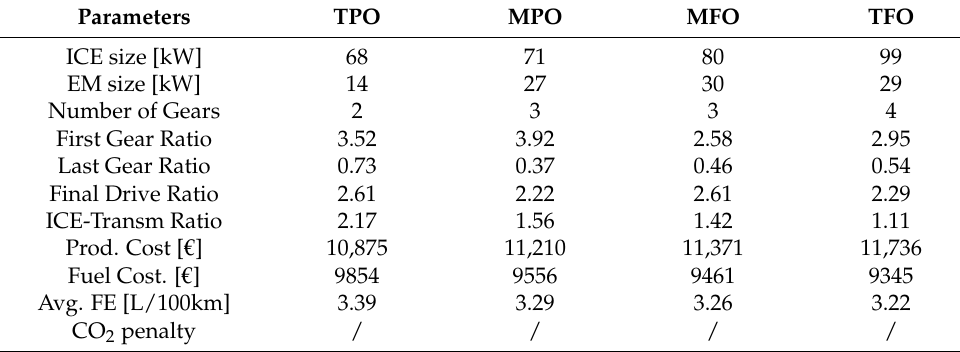
Table 5. Optimal HEV layouts’